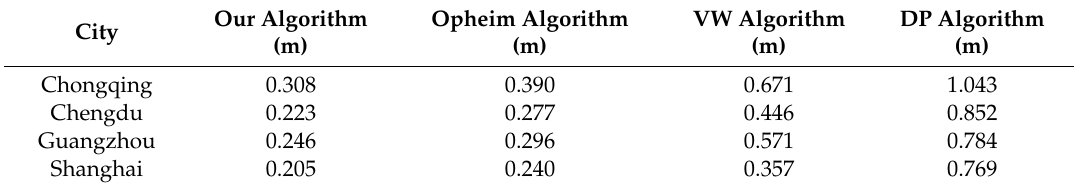
Table 3. The average changes in the azimuth angle in the spatial directional relationship.